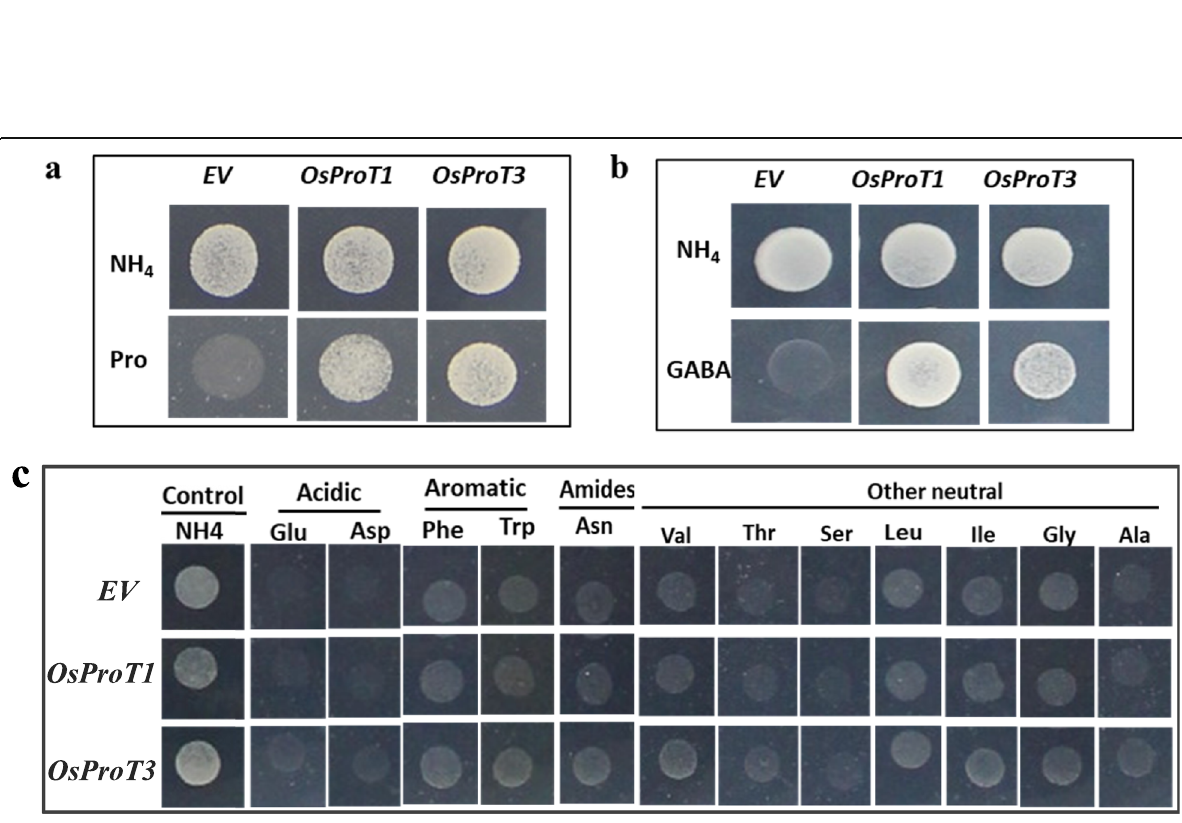
Fig. 2 Subcellular localization of eGFP-OsProT fusion proteins in Arabidopsis mesophyll protoplasts. eGFP-OsProT1 or eGFP-OsProT3 was driven by the 35S promoter and transiently expressed in Arabidopsis protoplasts. The fluorescent dye Dil at a concentration of 10 μ M was used to indicate the plasma membrane. Bars = 10 μ m